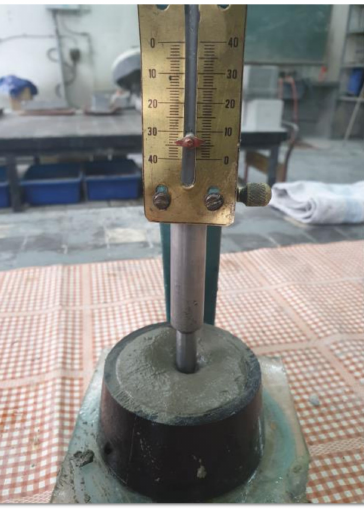
Figure 5. The view oement paste with MSWI slag under Chateliera’s test (authors’ photo).